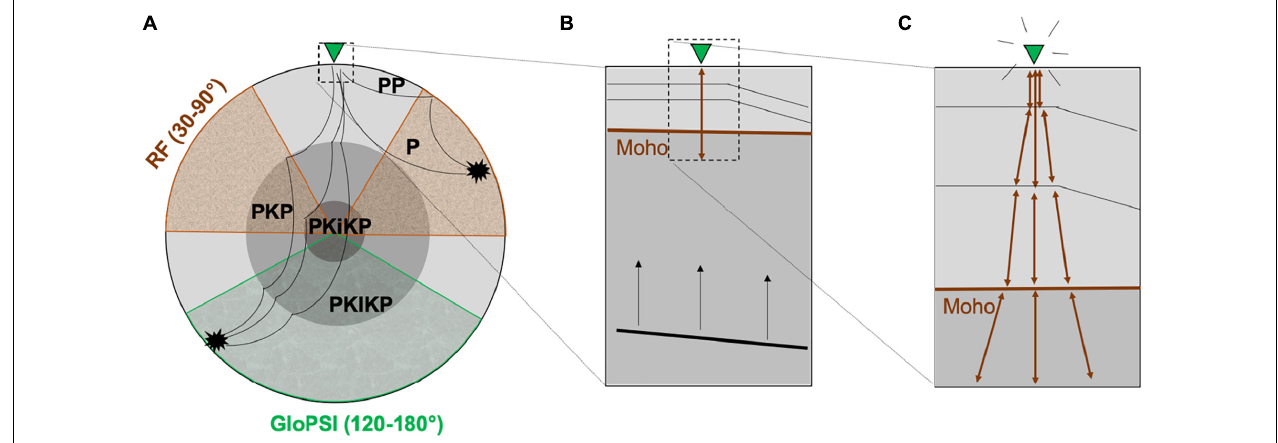
FIGURE 2 | (A) Illustration of raypaths (black lines) between a source (black star) and a receiver (green triangle) for the most prominent P phases. The typical epicentral distances for GloPSI and RF are marked with shading. (B) Close-up of the medium below the receiver, with a global phase wavefront just before it impinges on the lithosphere. (C) Illustration of exemplary zero-offset reflection responses used in GloPSI (modified from Ruigrok and Wapenaar,